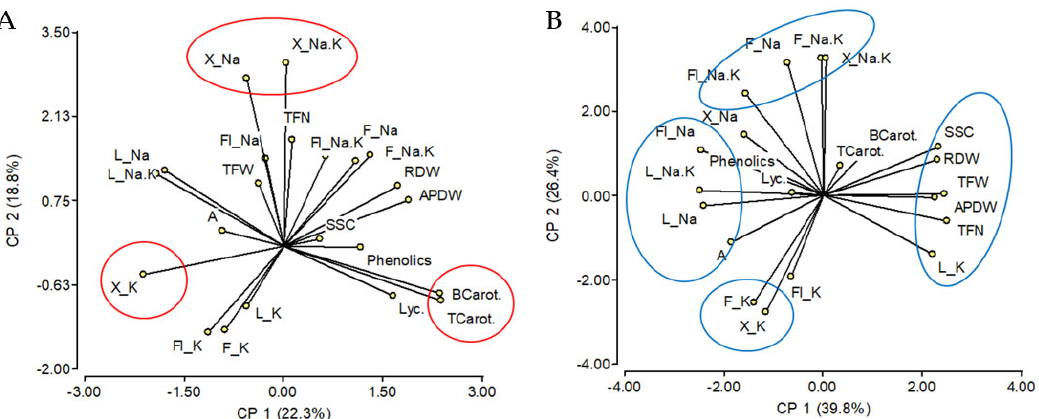
Figure 2. Graphic representation (biplot) of principal component analysis of variability found among the 16 rootstock/scion SgHKT1 genotypic combinations under ( A ) control condition (0 mM NaCl), and ( B ) salinity (70 mM NaCl) for evaluated traits (agronomical, physiological, and vegetative plant traits). Closely related traits are encircled. (TFW): R2 × E, R2 × S1, and R1 × S1 (Figure 3A,B,C, respectively). Arrows in all figures